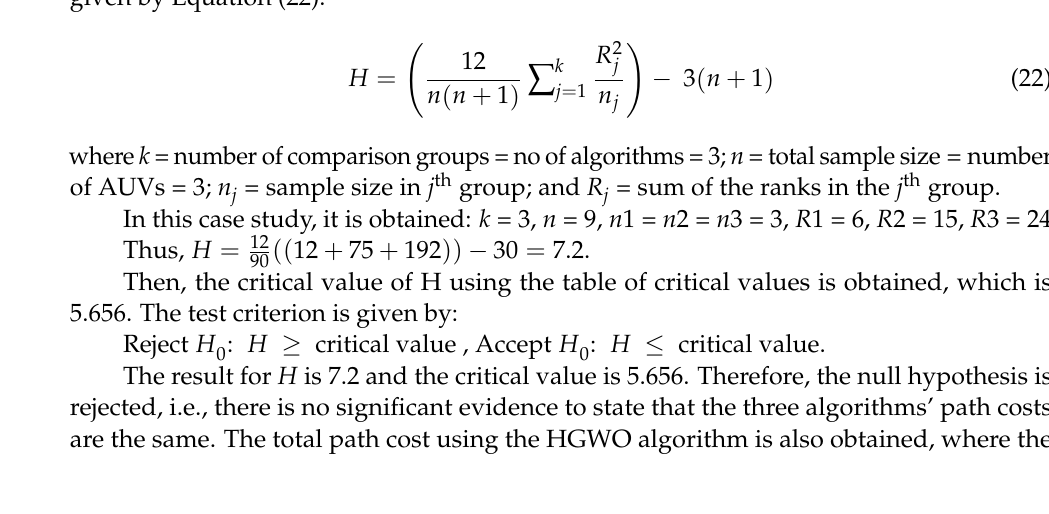
Table 2. Analysis of the GA, GWO and HGWO performances for path planning of multiple AUVs. Algorithm